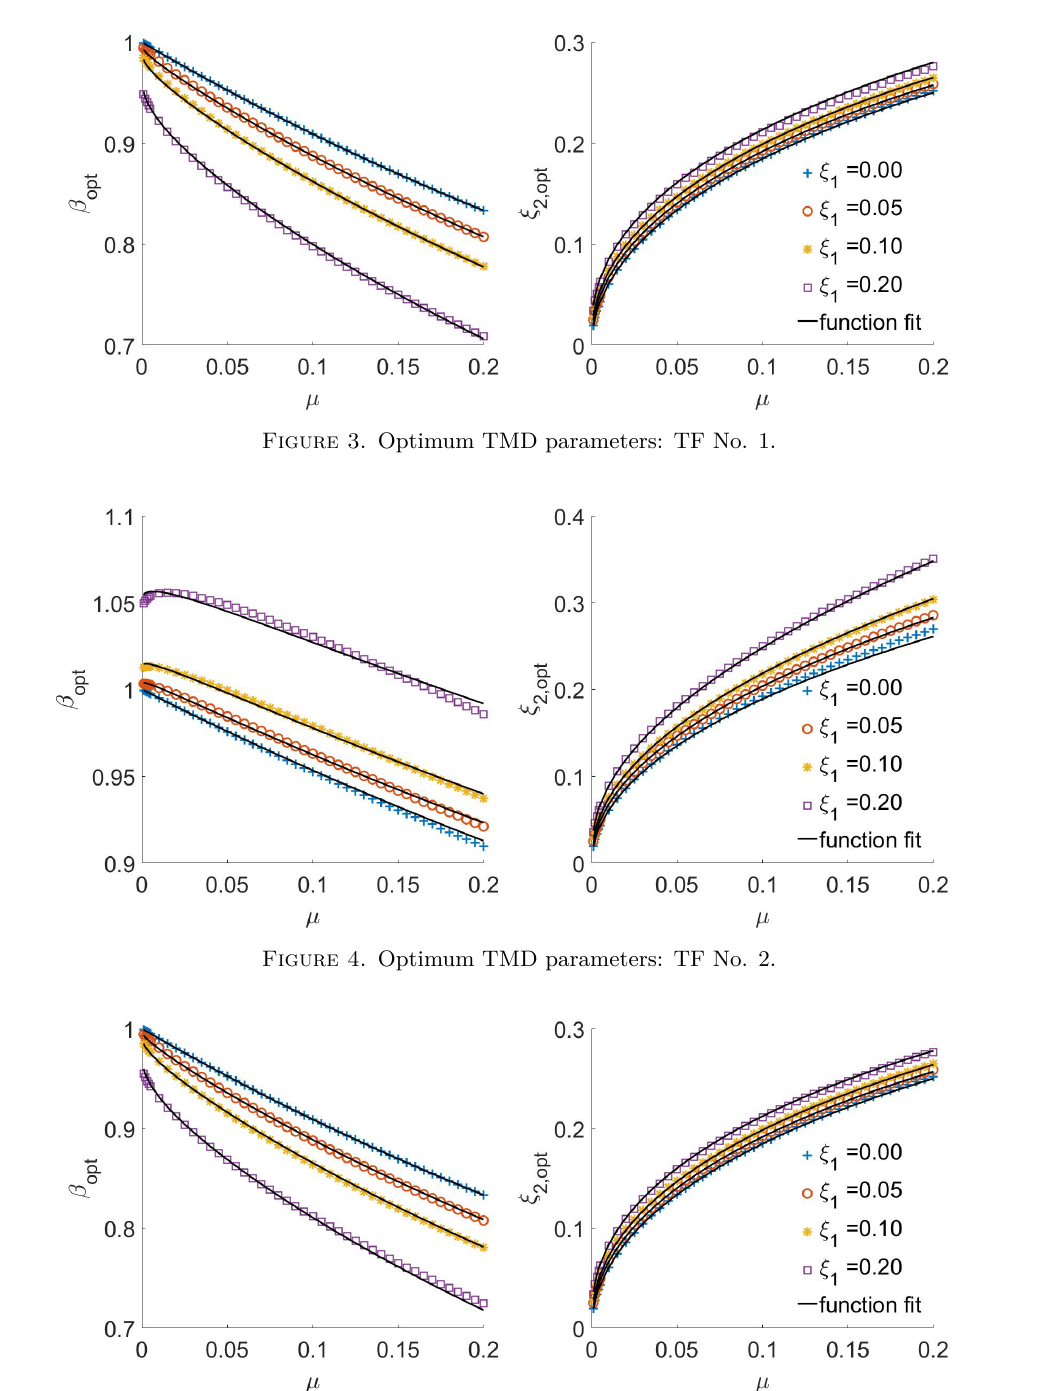
Table 2. Coe ffi cients a i and b i for design equations (2) and (3).